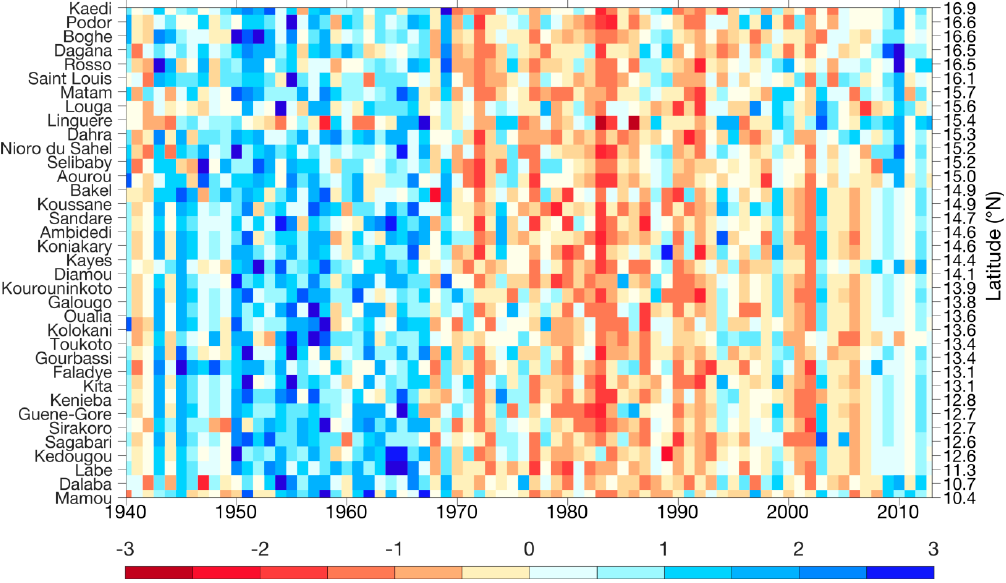
Figure 5. Variation of SPI over the period 1940–2013.